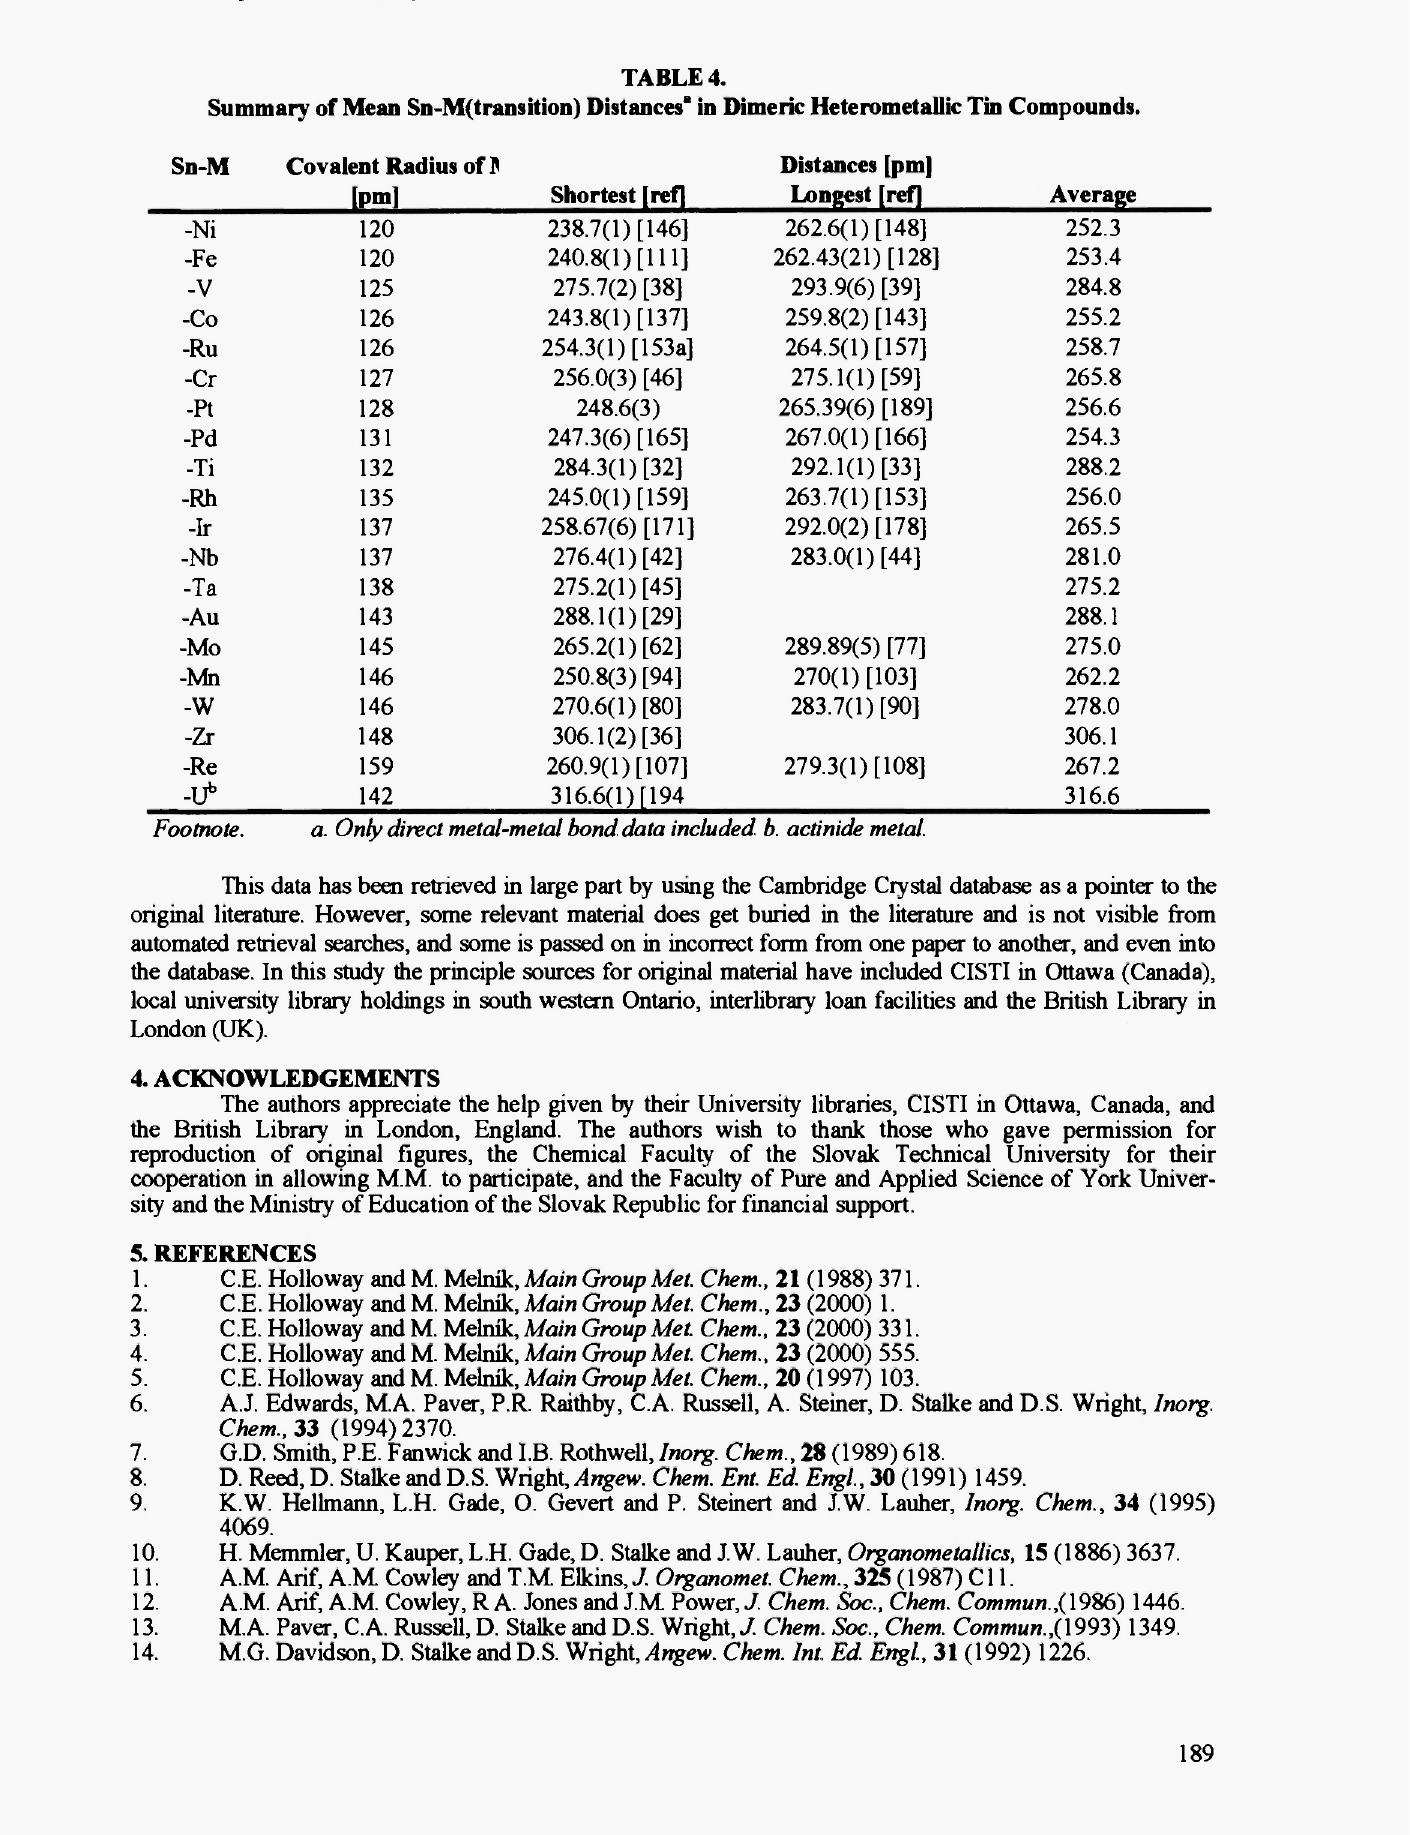
Summary of Mean Sn-M(transition) Distances" in Dimeric Heterometallic Tin